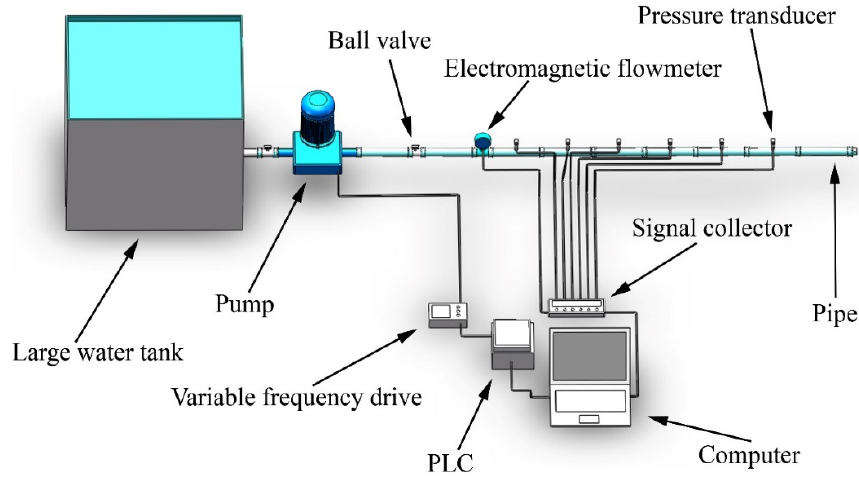
Figure 2. Experimental setup for testing oscillating water flow in a pipe.